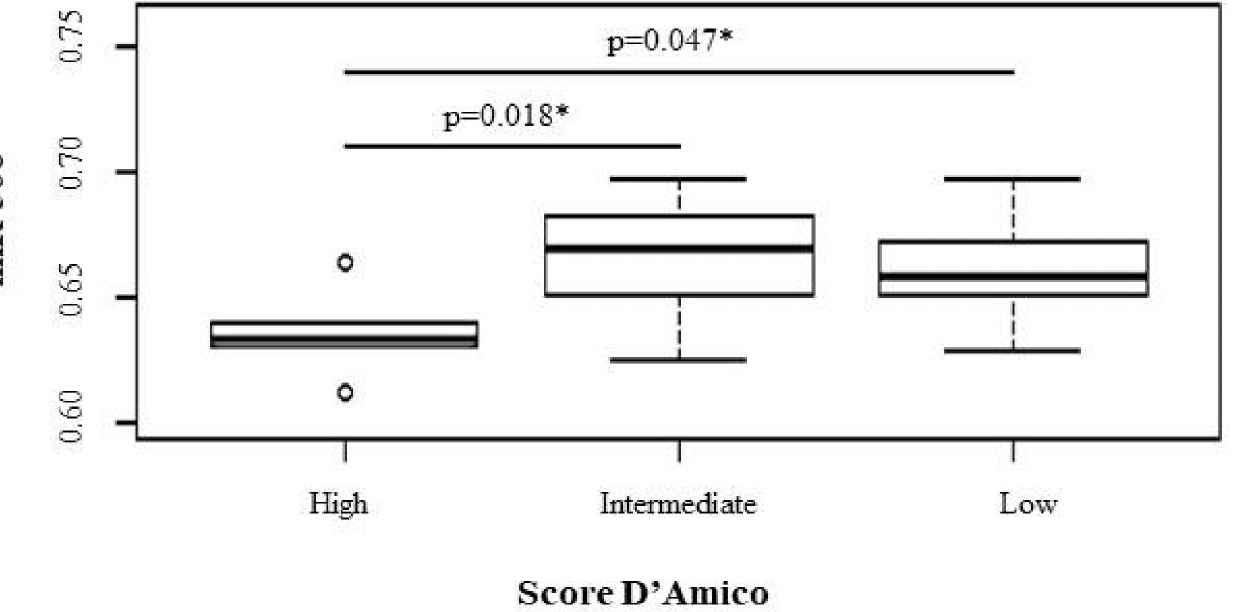
Figure 4. Distribution of Score D’Amico and relative prostatic levels of miR 506 in patients with CaP. * significative p value (<0.05). All p values were determined using the Mann-Whitney test. The Y axis represents the expression of miRNA by the Western blotting method and the X axis represents the distribution of the sample from the case group according to risk stratification D’Amico